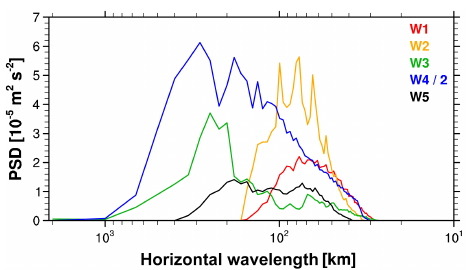
Figure 6. Horizontal-wavelength power spectra of w (cid:48) at z = 8km averaged over 24h from 12:00UTC on day 6 for W1 (red), W2 (yellow), and W3 (green) and from 00:00UTC on day 7 for W4 (blue) and W5 (black). The spectra for W1–W5 were obtained from the spectral domains 1–5 indicated in Fig. 4, respectively. For W4, the power spectrum is divided by